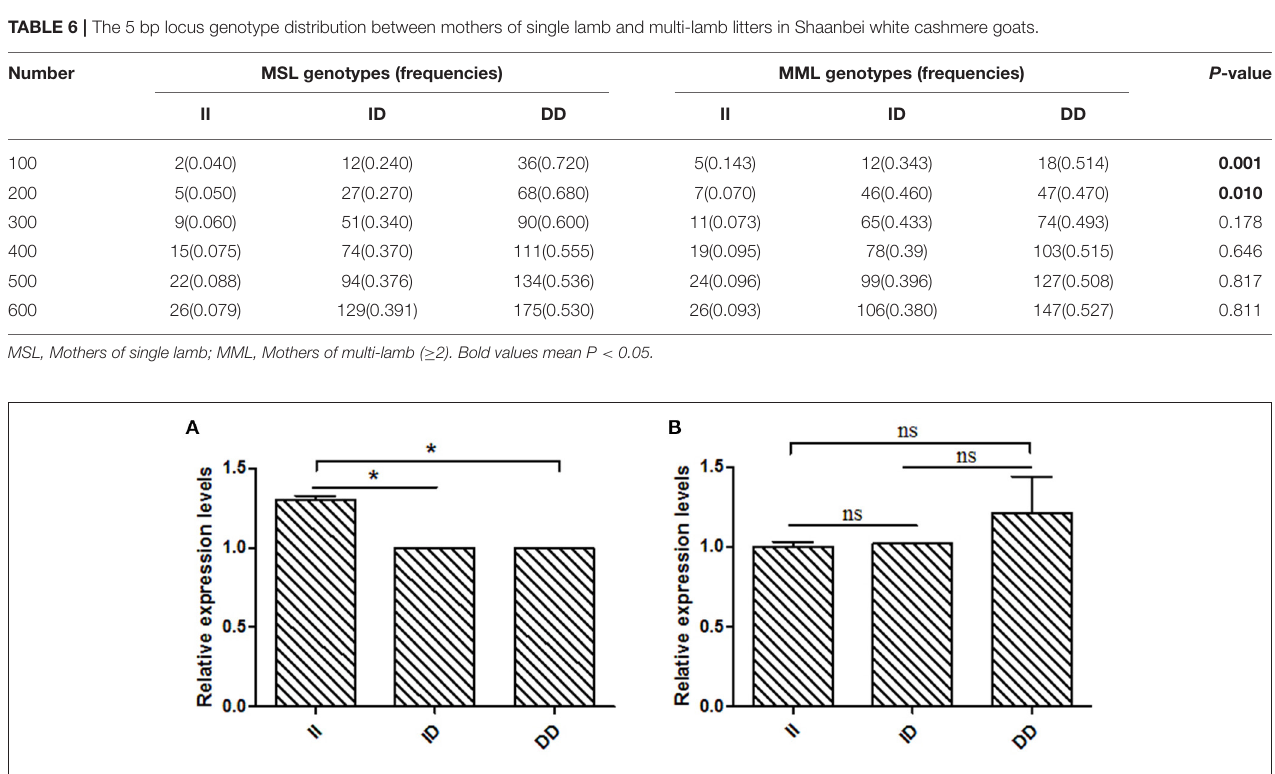
of KDM6A genetic effects in the female Shaanbei white cashmere goat